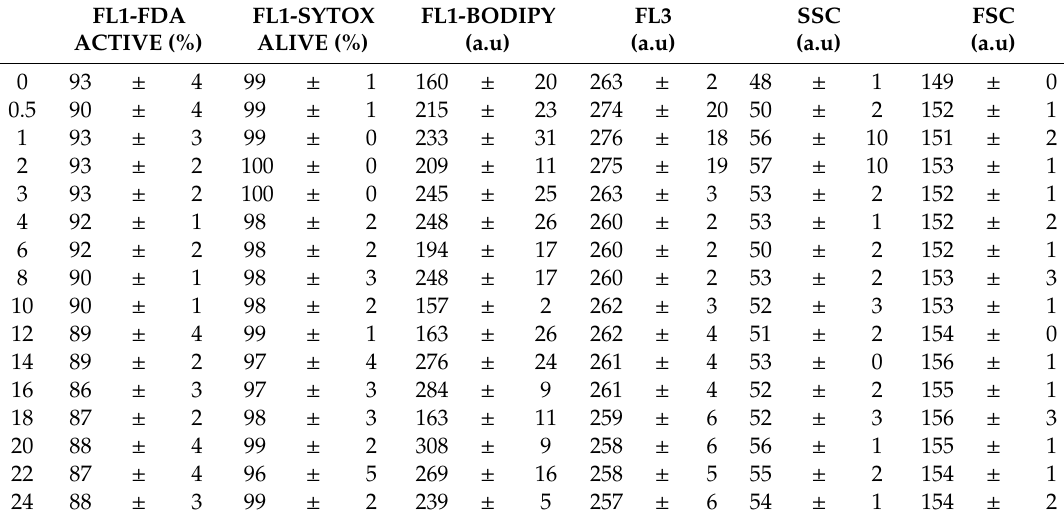
Table 3. Cellular parameters of C. muelleri using flow cytometry analysis (Mean ± SD, n = 3) according to sampling time. Control and enriched balloons were combined for this table as no di ff erences were observed between balloons. Values for FDA and SYTOX are in %, values for BODIPY / FL3 / SSC / FSC in arbitrary unit (a.u).